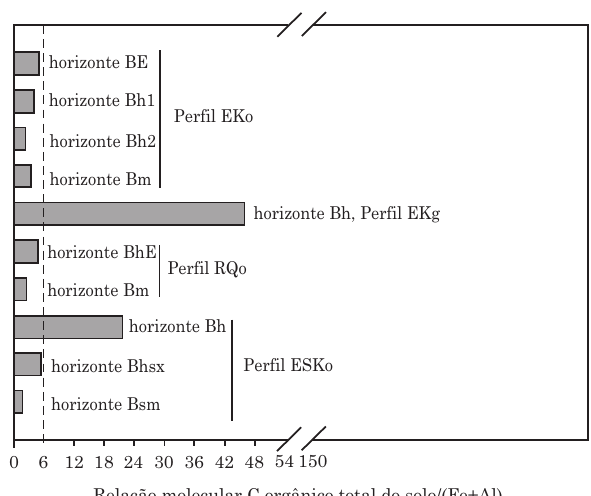
Figura 4. Relação molecular C orgânico total e soma das extrações de Fe e Al extraídos por pirofosfato de sódio [CO/(Fe+Al) p ] de horizontes iluviais (espódicos e cimentados) dos solos estudados. A linha tracejada corresponde ao valor mínimo (= 6) da relação, conforme proposto por Monka & Buurmann (1982), em que a matéria orgânica ainda estaria apta a reter íons